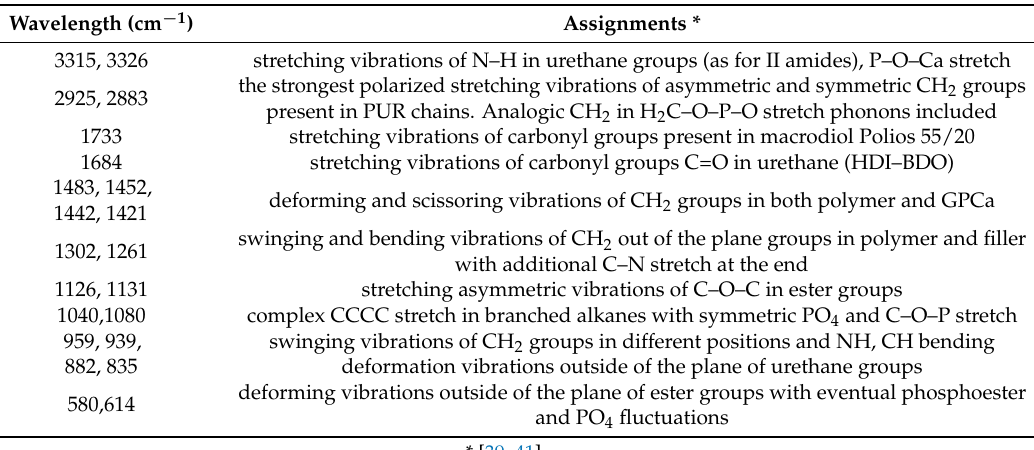
Table 4. Raman spectra band assignments for GPCa modified